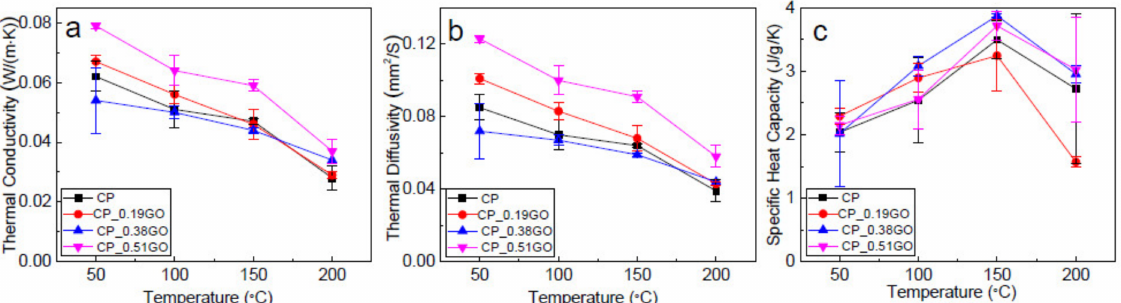
Figure 8. Thermal properties of cotton/PLA composites with and without GNP coatings. ( a ) Thermal conductivity; ( b ) thermal diffusivity; ( c ) specific heat